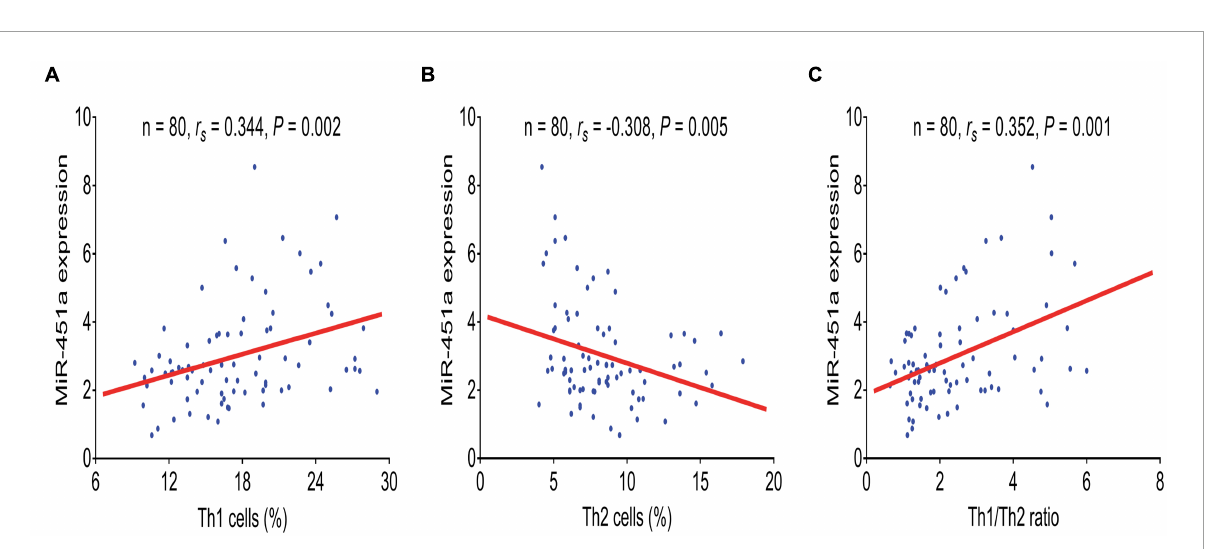
FIGURE2 MiR-451a was positively correlated with Th1 cells and the Th1/Th2 ratio. Association of miR-451a with Th1 cells (A) , Th2 cells (B) , and the Th1/Th2 ratio (C) in patients with